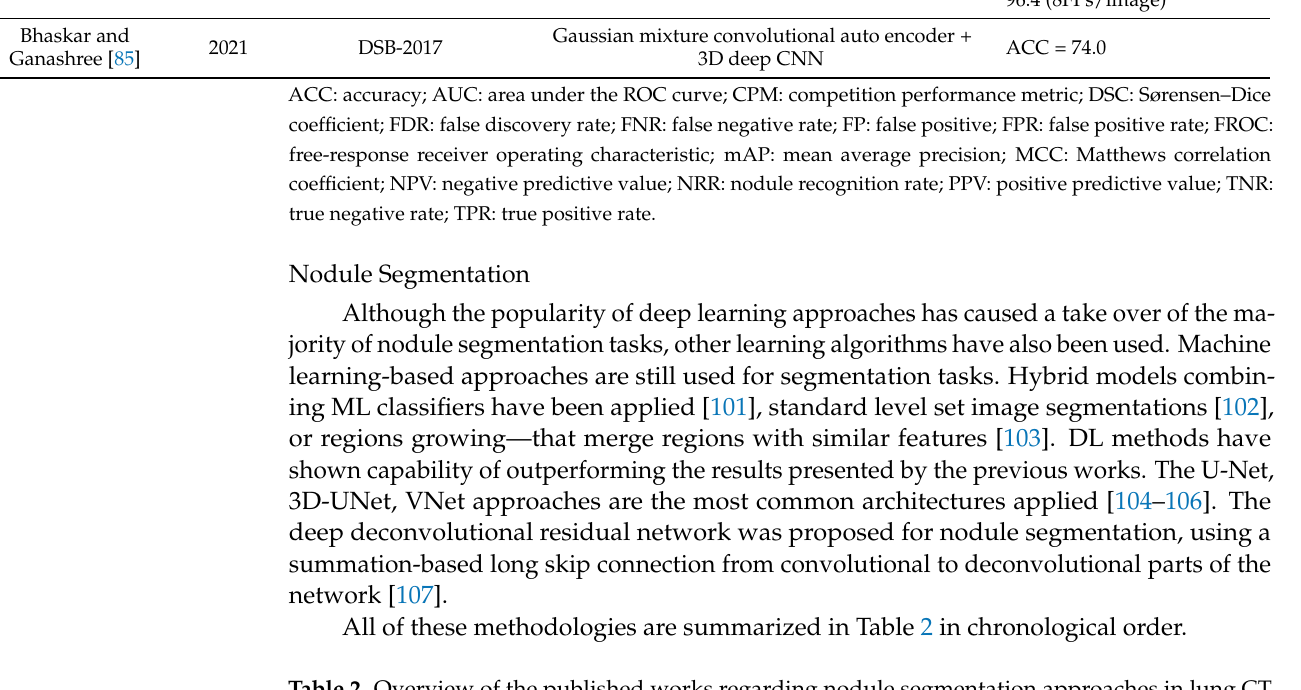
Table 2. Overview of the published works regarding nodule segmentation approaches in lung CT images